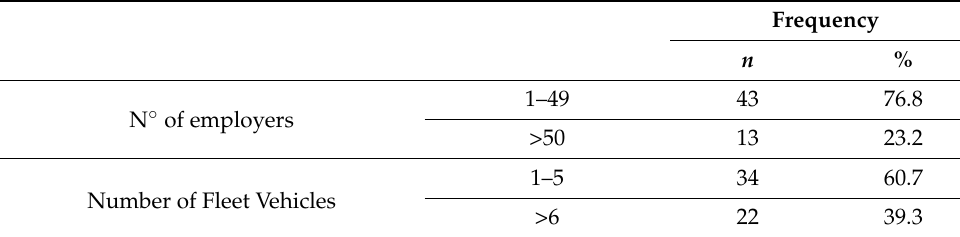
Table 5. Descriptive analysis of respondents to the questionnaire related to the BS.